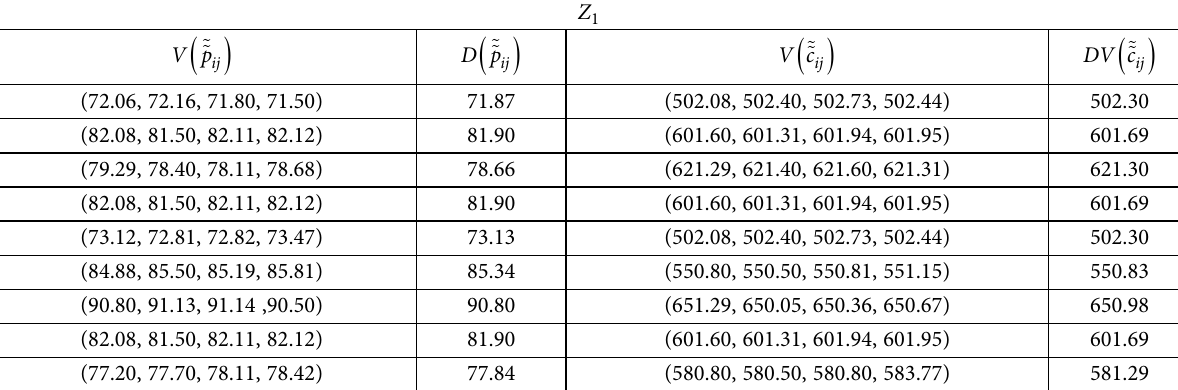
Table 4. Defuzzifucition Phases 1 and 2 crisp values of profit and